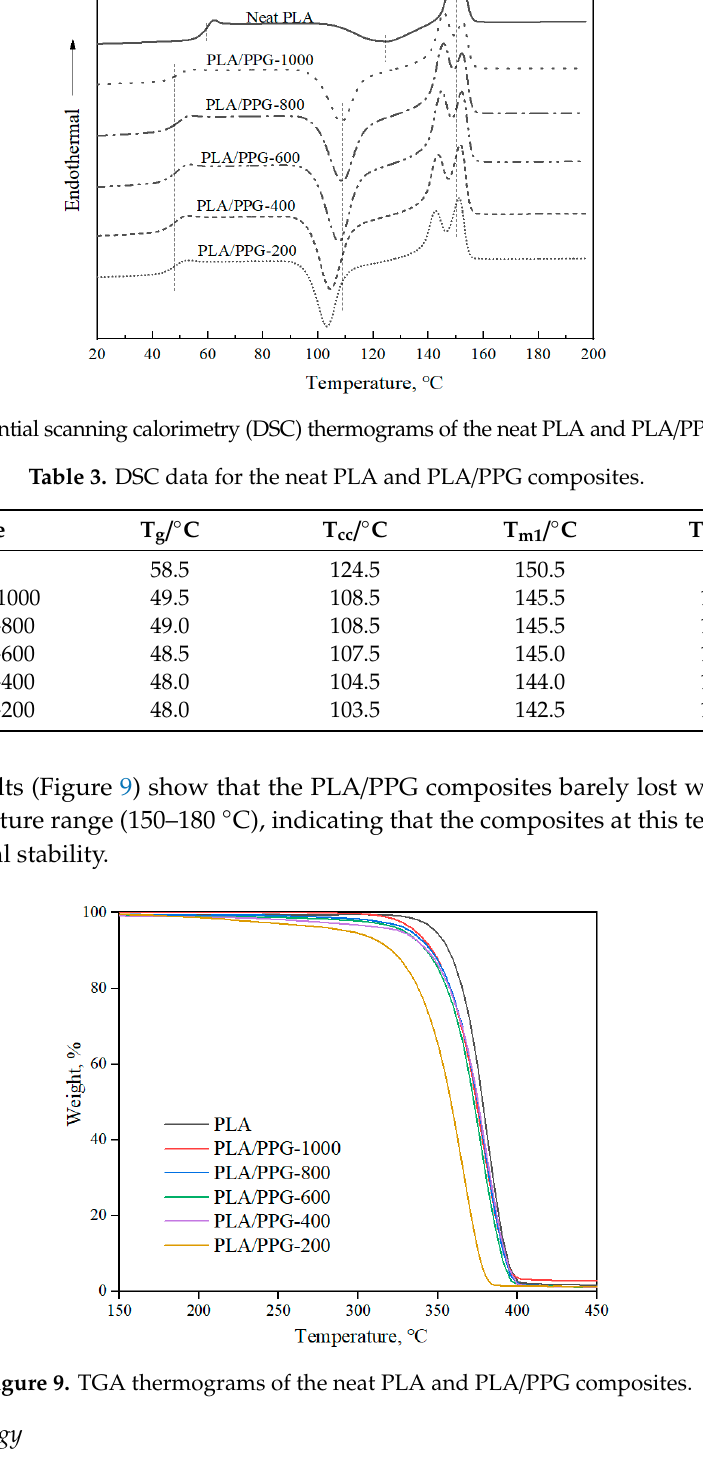
Figure 8. Differential scanning calorimetry (DSC) thermograms of the neat PLA and PLA/PPG composites. Table 3. DSC data for the neat PLA and PLA/PPG composites.